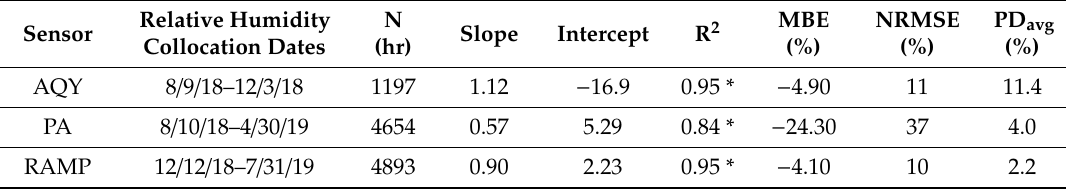
Table 3. Average relative humidity linear regression parameters a for 2 sensors of each type at AIRS during ambient monitoring.